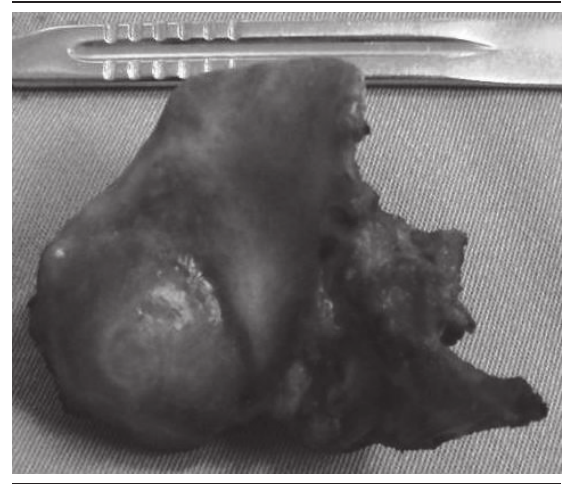
figurE 2 – Surgical specimen (case 1) Supraglottic partial laryngectomy product. A single and submucosal lesion placed on the left side of supraglottis is